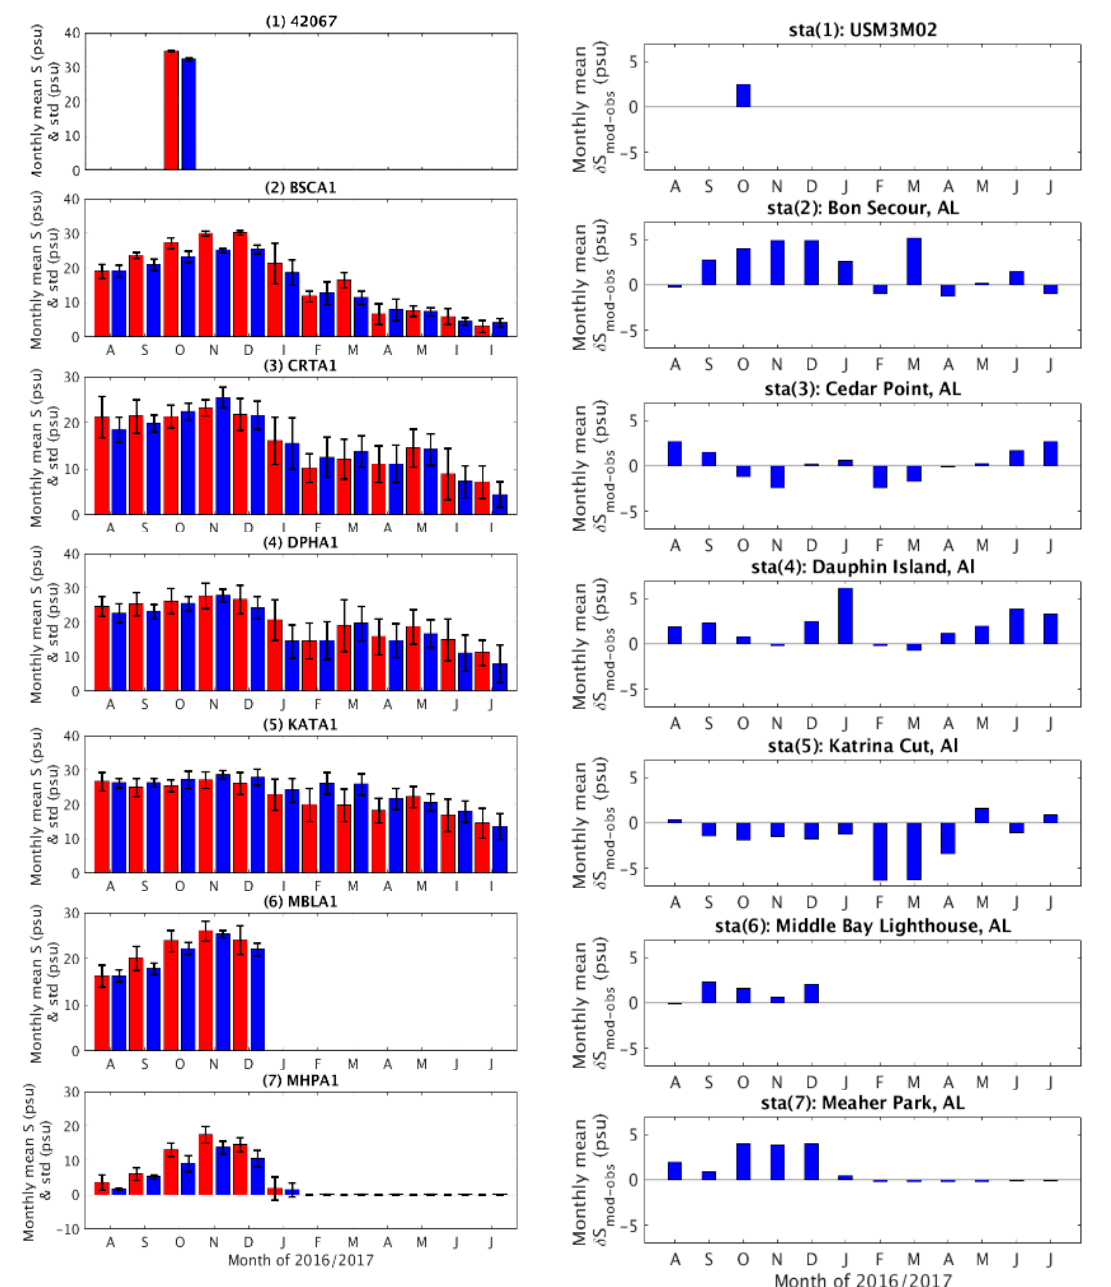
Figure 17. Comparison of monthly mean SSS between the hindcast results and observation, (left panel) monthly mean SSS of model (red bars), observations (blue bars), and the standard deviation of each data set and (right panel) monthly mean model bias. The station IDs are shown in the title of each plot. See the station locations in Figure 1.